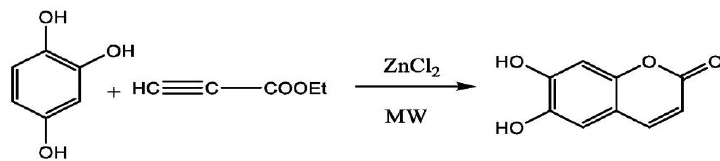
Figure 8. Synthesis of esculetin using microwave irradiation method.